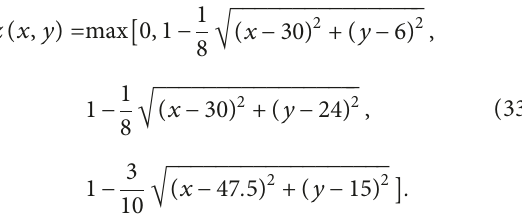
Figure 5: The computational domain, RBF collocation points, and location of the circular dam break problem.